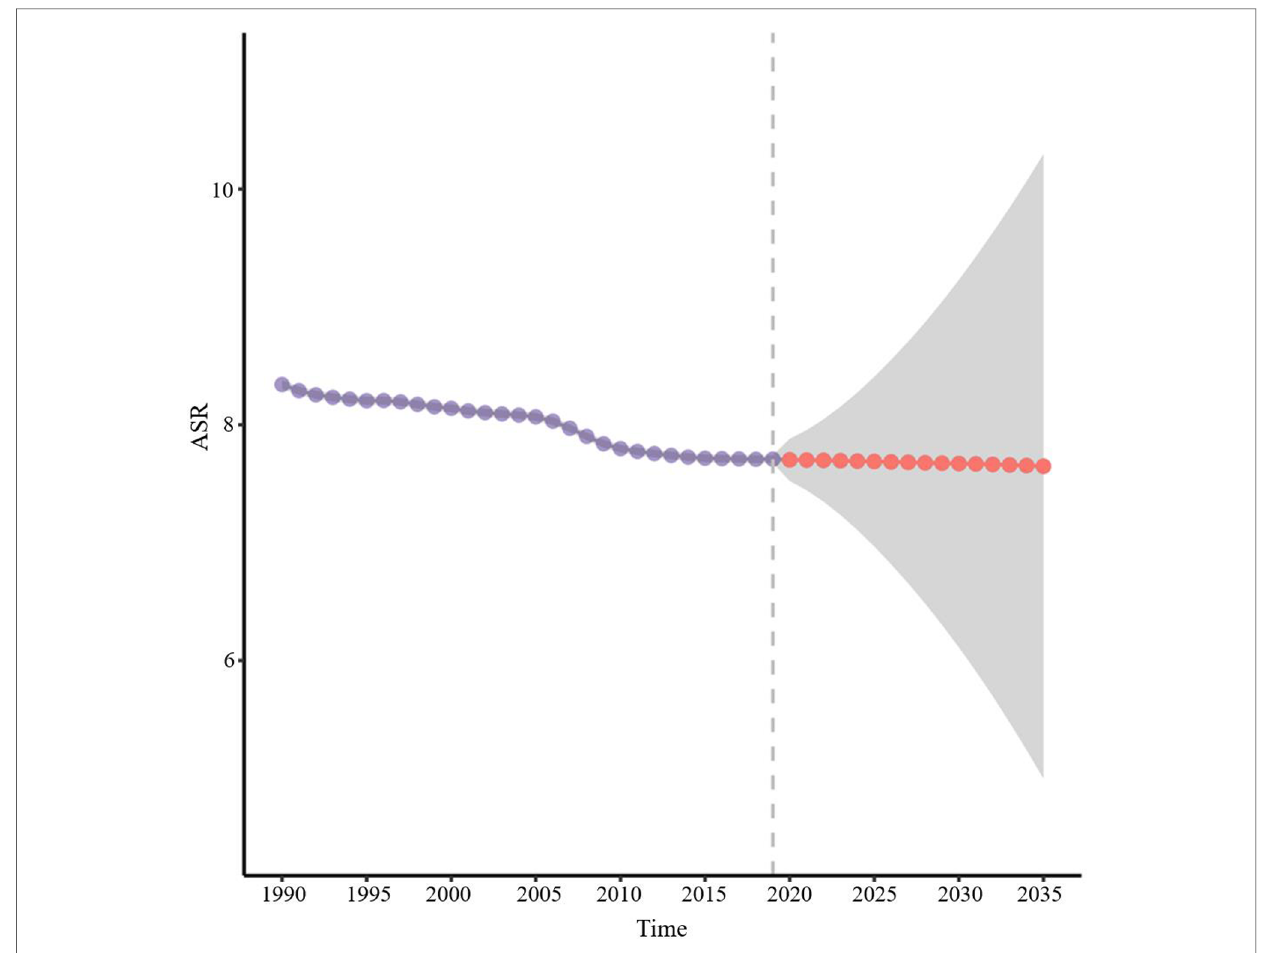
FIGURE 12 Prediction of the incidence rate of childhood myocarditis and cardiomyopathy for 2035. The age-speci fi c incidence rate of childhood myocarditis and cardiomyopathy is projected to show a slow decline in